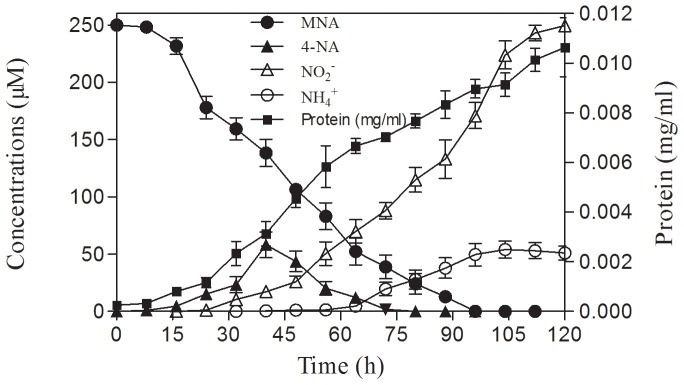
Growth of Pseudomonas sp. strain FK357 on MNA as the sole carbon, nitrogen, and energy source.(•), MNA; (▴), 4-NA; (Δ), NO2
−
; (▪), total protein; (○), NH4
+. Values are presented as arithmetic mean of data obtained from experiments carried out in triplicate; error bars represent standard deviation.